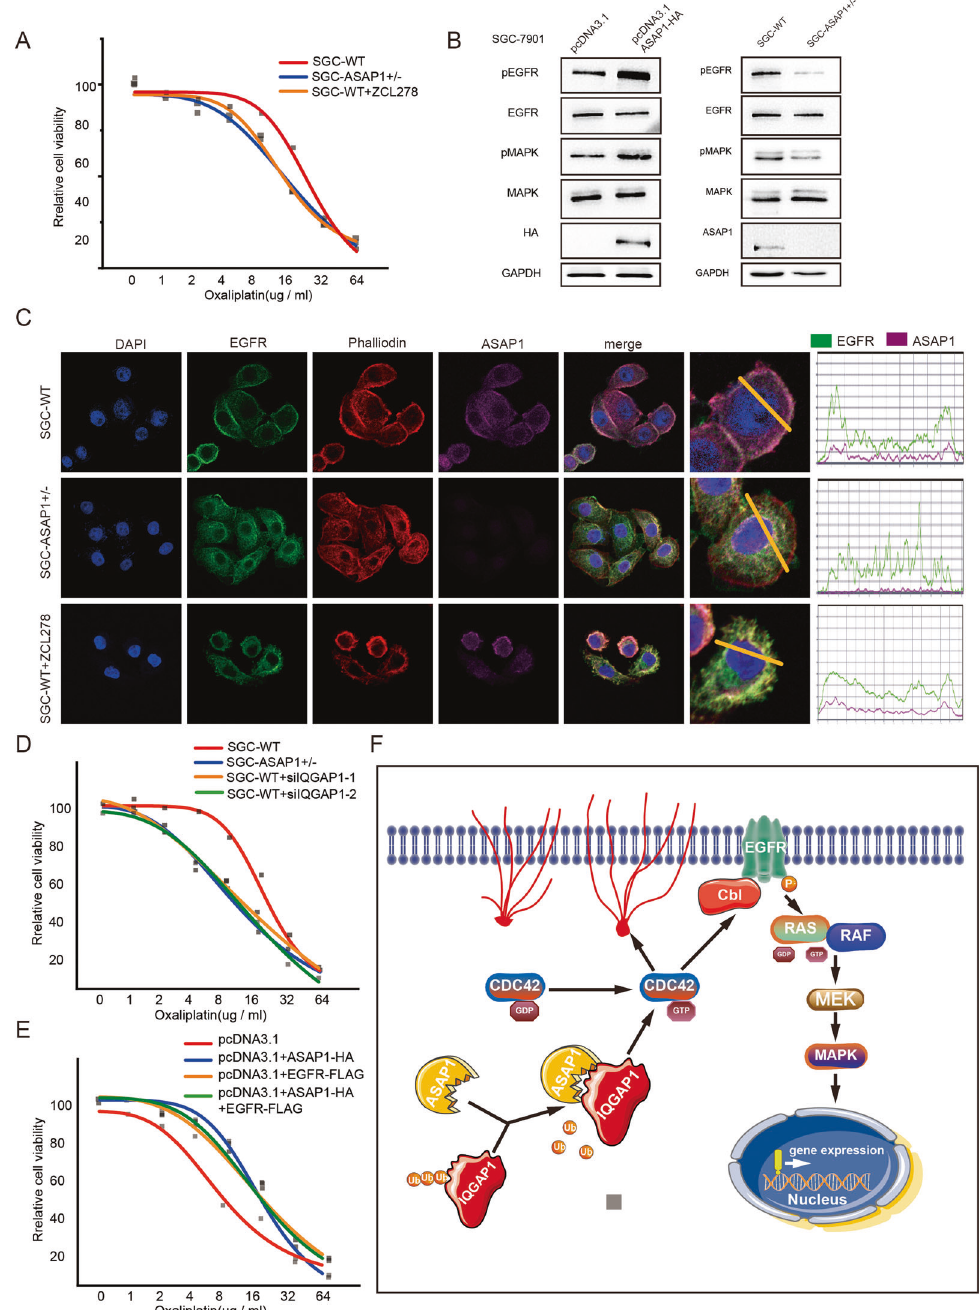
Fig. 8 ASAP1 upregulated EGFR-MAPK pathway and promotes chemotherapy resistance by activating CDC42. A The effect of ZCL278 on the viability of WT SGC-7901 cells in response to oxaliplatin. Cell viability was measured by CCK-8. IC50 values in two different drug treatments are shown ( n = 3). B WB analysis of EGFR-MAPK pathway in SGC-7901 cells expressing ASAP1-HA and partially knocked out of ASAP1. C Phalloidin staining for F-actin (red) and EBFR (green) immuno fl uorescence. Nuclei were counterstained with DAPI (blue). In ASAP1 ± SGC-7901 cells, the EGFR was not located on the membrane and the cytoskeleton depolymerized. In WT SGC-7901 cells treated with ZCL278, the EGFR was not located on the membrane and the cytoskeleton depolymerized. D The effect of IQGAP1 on the viability of SGC-7901-ASAP1 ± cells in response to oxaliplatin. Cell viability was measured by CCK-8. IC50 values in two different drug treatments are shown ( n = 3). E The effect of EGFR on the viability of SGC-7901 cells expressing ASAP1-HA or not in response to oxaliplatin. Cell viability was measured by CCK-8. IC50 values in two different drug treatments are shown ( n = 3). ns-not signi fi cant; * p < 0.05; ** p < 0.01; *** p < 0.001. F A working model of ASAP1 summarizing this study. ASAP1 was highly expressed in gastric cancer, inhibits ubiquitin- mediated degradation of IQGAP1 and promotes CDC42 activation through interaction with IQGAP1. Activated CDC42 contributes to the growth and metastasis of gastric cancer cells. In addition, activated CDC42 upregulates the EGFR pathway and causes oxaliplatin resistance in gastric